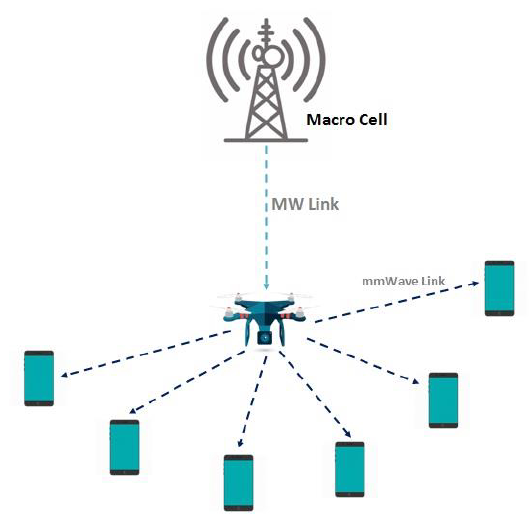
Fig 13. Macro cell to UE via UAV UAV Assisted Vehicular Communication